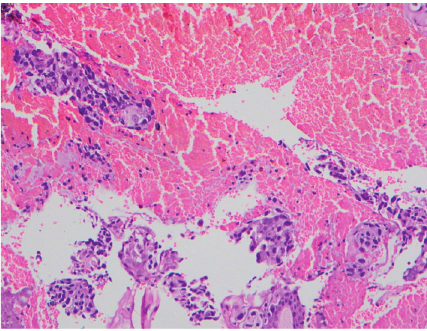
Figure 5: Histology of the biopsy taken from—endobronchial tumor at bronchoscopy—atypical cell clusters with oval and polygonal cells mixed with blood. Cells contain enlarged, hyperchromatic, pleomorphic nuclei and eosinophilic cytoplasm, and prominent nucleoli, compatible with adenocarcinoma of lung (H&E stain ×